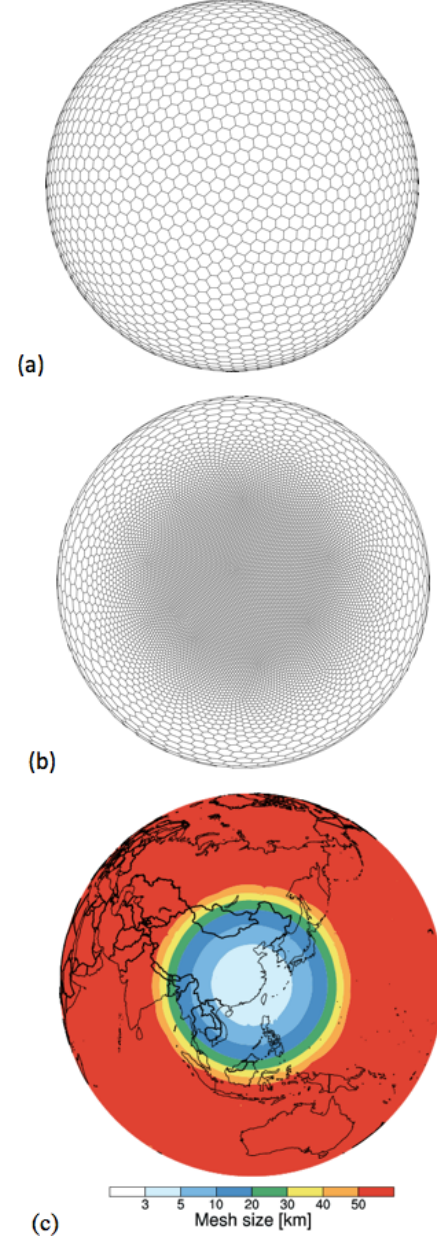
Figure 1. (a) Quasi-uniform mesh and (b) variable-resolution mesh used in the MPAS experiments. Both meshes are plotted at resolu- tions significantly lower than used in the experiments to show the mesh cells. (c) Global variable-resolution mesh size distribution in the variable-resolution 4–60km